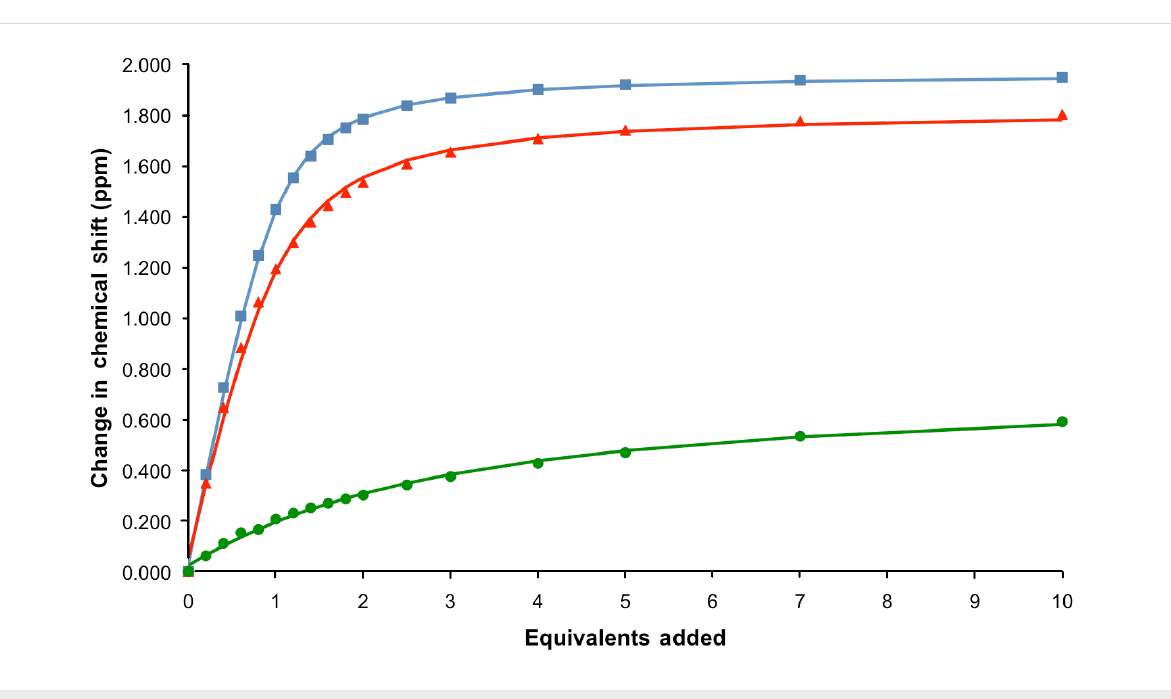
Figure 3: Titration data (solid points) and fitted binding isotherms (curves) monitoring the triazolium proton, d, for titration of benzoate, chloride and iodide into a solution of 5 · 2PF 6 (500 MHz, 293 K, CD 3